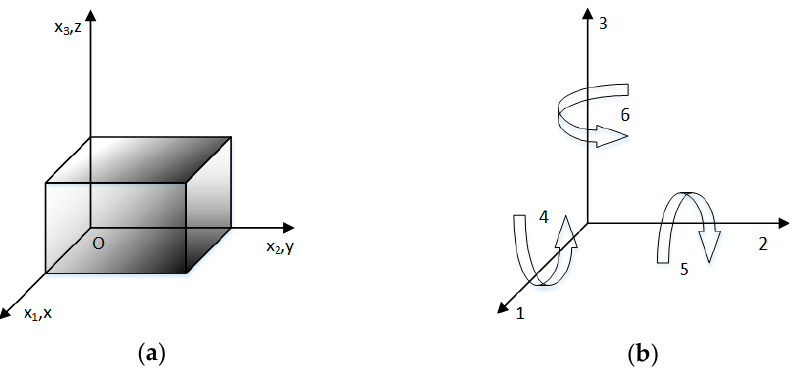
Figure 5. ( a ) The piezoelectric model and ( b ) coordinate system.